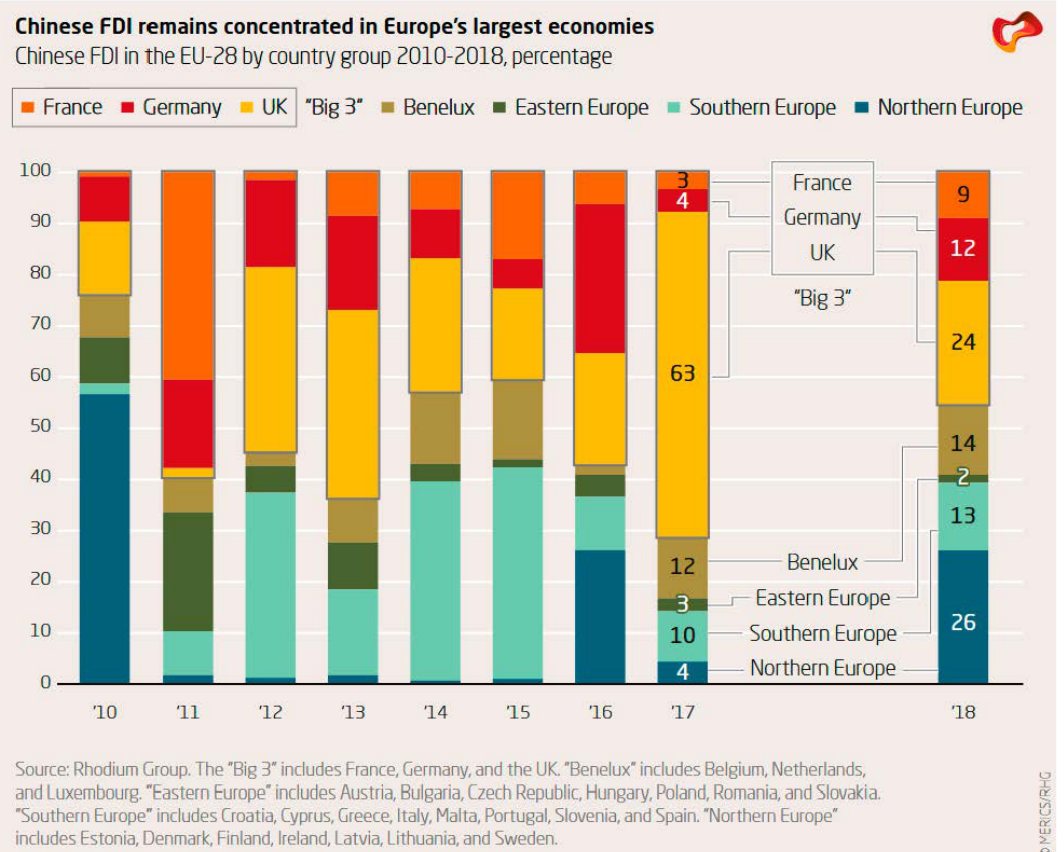
China’s FDI in the EU (2010–18). Source: Thilo Hanemann, Mikko Huotari and Agatha Kratz, ‘Chinese FDI in Europe: 2018 Trends and Impact of New Screening Policies’ (2019)